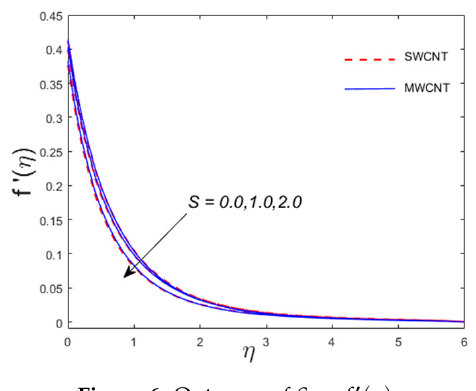
Figure 5. Outcome of Pm vs. g (cid:48) ( η ) .